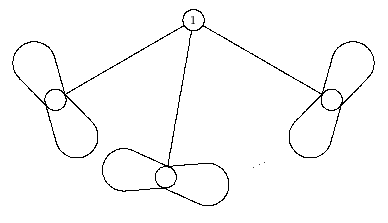
Fig. 4: The combinatorial decomposition of a non-crossing